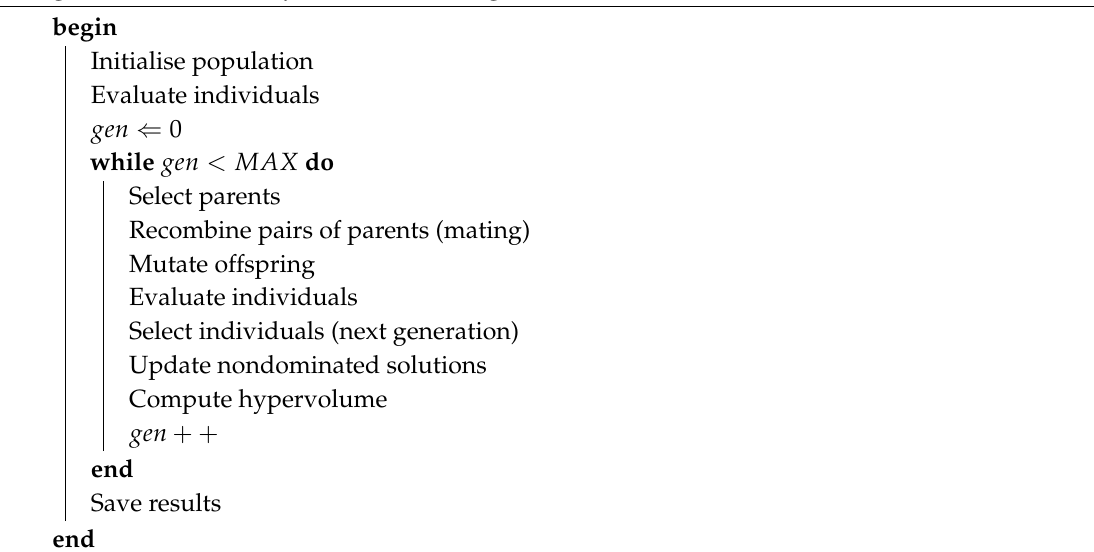
Algorithm 1: Multi-Objective Genetic